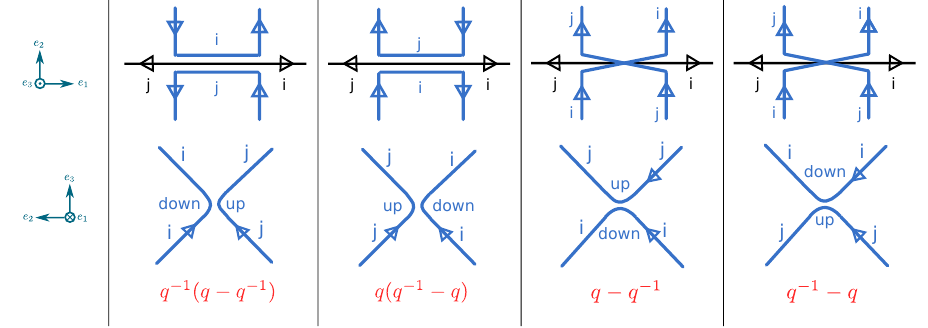
Figure 19 . Exchange factors contributing to the overall weight (cid:11) ( e L ). The exchange factor depends on more data than we can represent in a single projection: we show the standard projection on top and the leaf space projection below. The picture represents e L rather than L , so in the leaf space instead of a crossing we see its resolution. The words \up" and \down" here describe the behavior in the x 1 -direction, since that is the direction not visible in the leaf space projection; hence \up" means pointing out of the paper and \down" means pointing into the